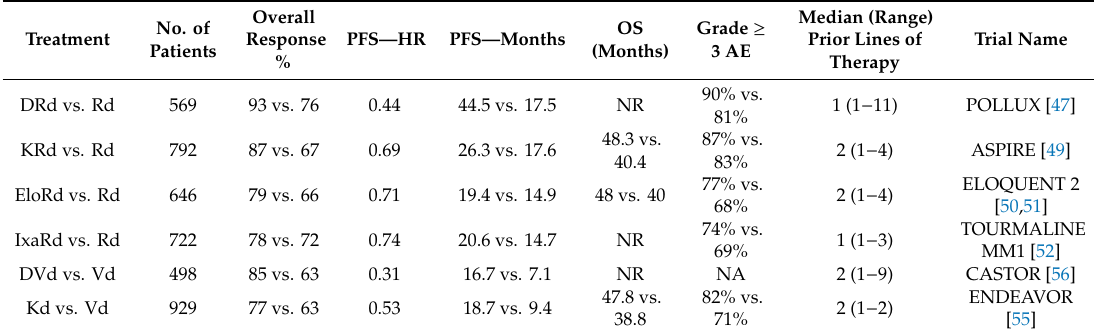
Table 3. Randomized clinical trials of first generation regimens in relapsed refractory multiple myeloma (RRMM).